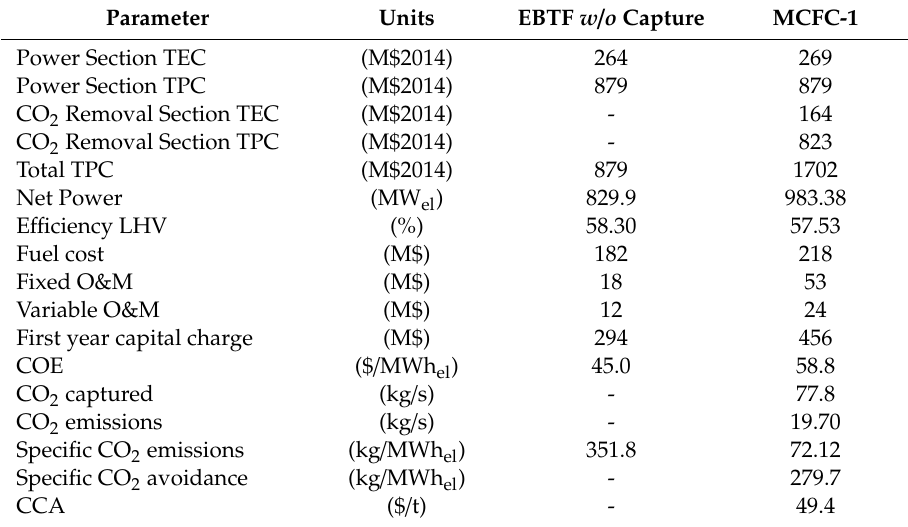
Table 16. MCFC general performance and costs